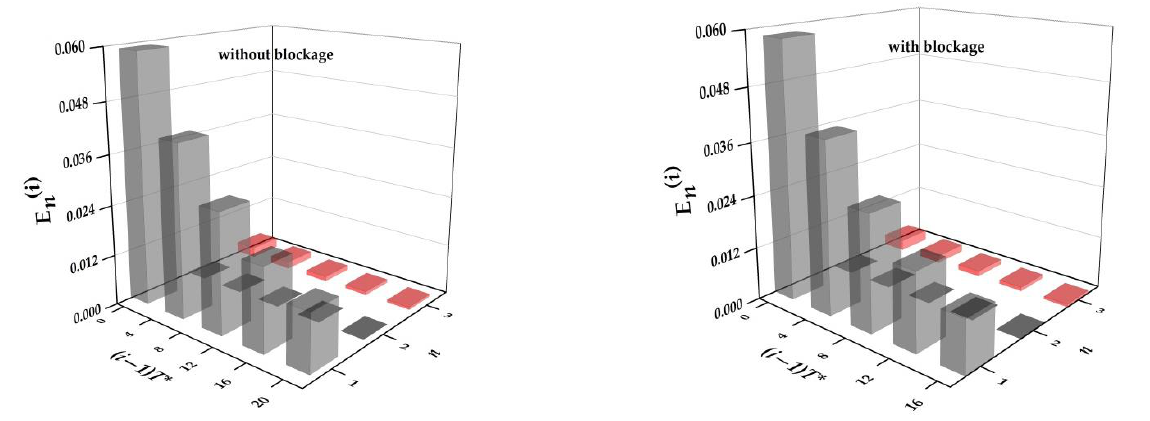
Figure 9. Amplitude of harmonics in different periods.